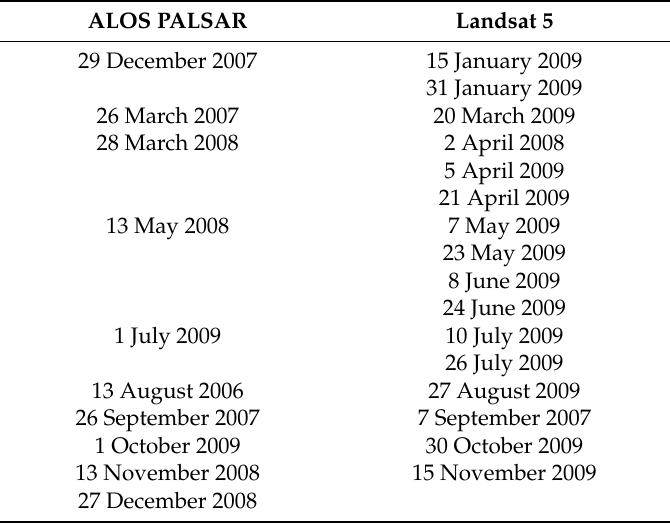
Table 1. Acquisition dates of satellite data at site A. ALOS PALSAR Landsat